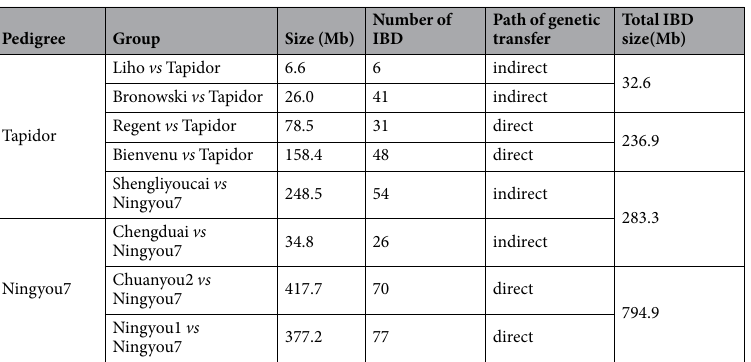
Pedigree Group Size (Mb)